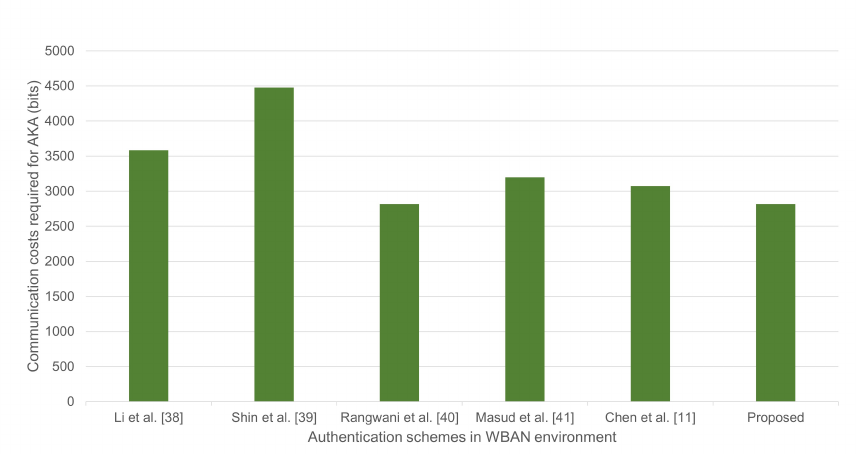
Figure 12. Communication cost comparison of related schemes [11,38–41].